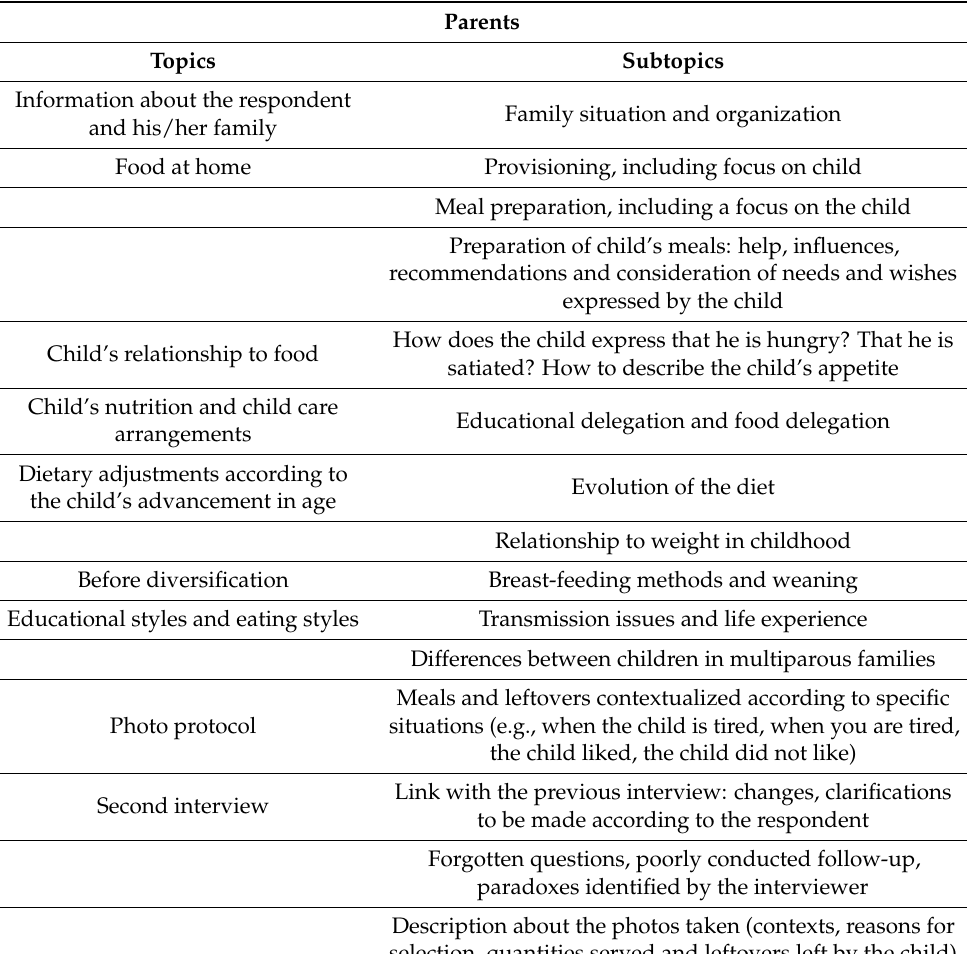
Table A1. Interview